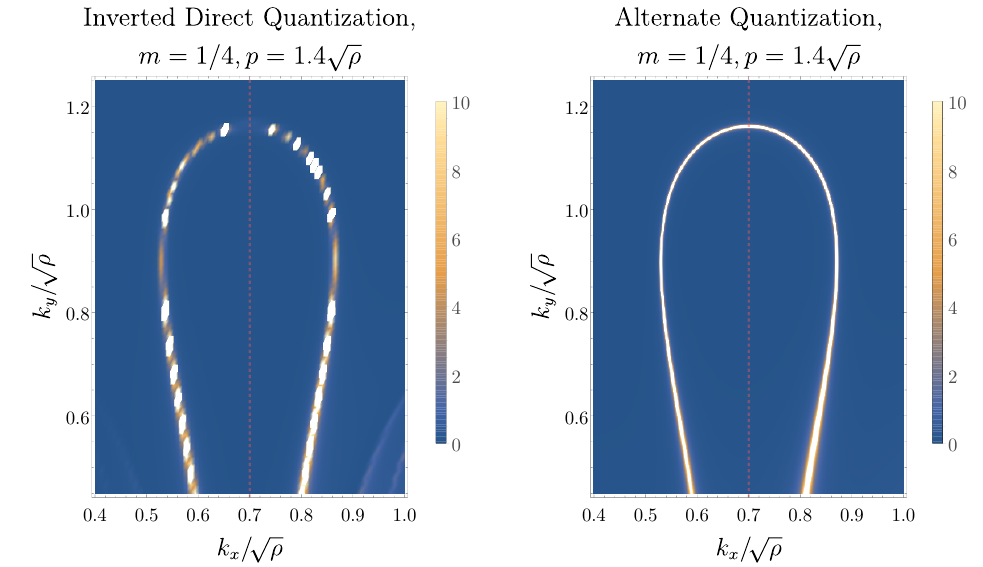
Figure 11 . Comparison of the two treatments of the alternative quantization picture. The com- parison between computation in alternate quantization and doing the inversion procedure from the direct quantization data. The main features (sharpness, shape, and the reduction of spectral p weight near ( k x ; k y ) = (0 : 65 ; 0 : 40) (cid:26) ) are demonstrably reproduced. The inversion procedure does su(cid:11)er from limited numerical precision, as the contributions from all the di(cid:11)erent Green’s func- tion components range over many orders of magnitude. The non-smoothness of the left-hand side arises because the width of the FS is smaller than the density of data points, causing the compu- tation to not quite hit the peak. This can be improved in principle, however due to the prohibitive computational cost of this procedure we don’t show it